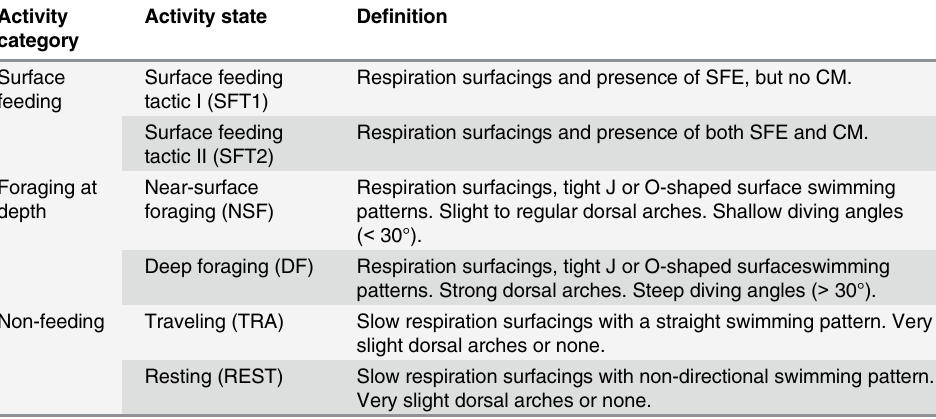
Table 1. Definition of activity states of minke whales in the St. Lawrence,